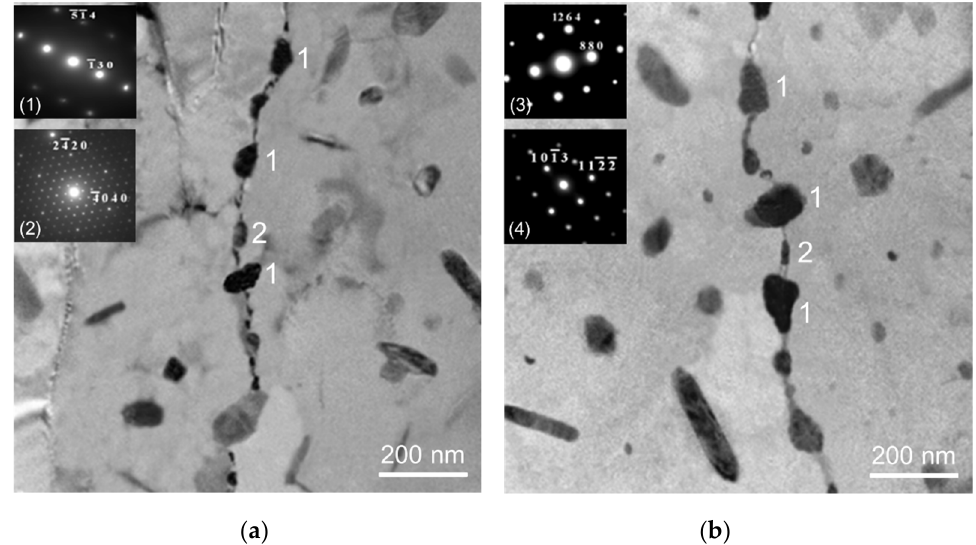
Figure 8. TEM photomicrographs of alloy D ( a ) homogenization, water quenching and sensitization for 1 day and ( b ) for 3 days (1: Mg 2 Al 3 , 2: MgZn 2 ).